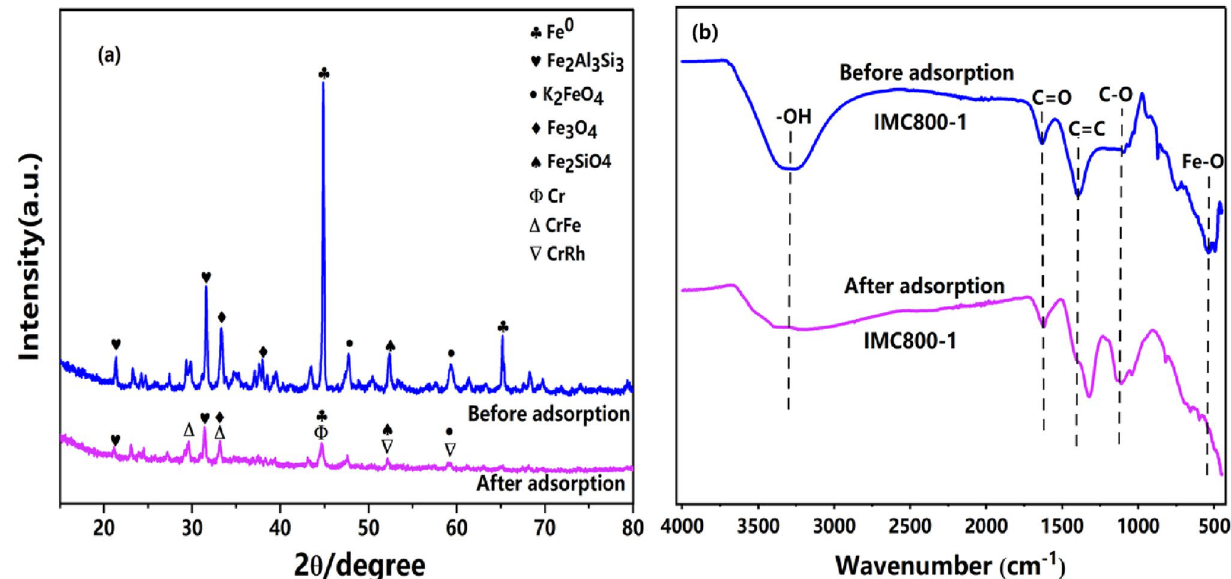
Figure 5. XRD patterns of IMC800-1 before and after adsorption ( a ), FTIR before and after adsorption ( b